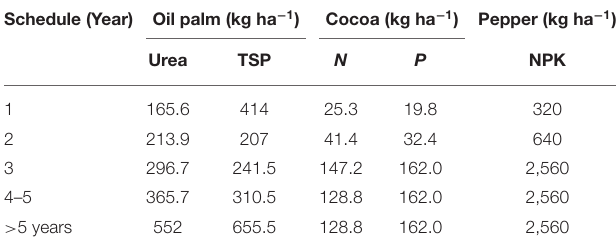
TABLE 2 | Dose and schedule of fertilizer application following Pahan (2015) for oil palm, Salim et al. (2009) for cocoa, and Manohara and Wahyuno (2013) for